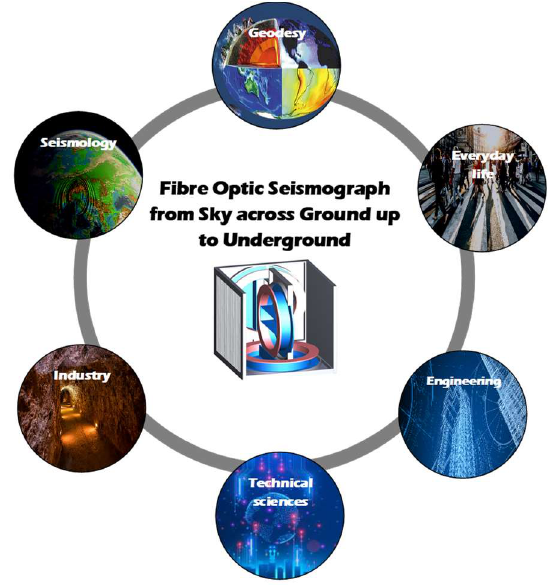
Figure 1. Visualization of three-axial fibre-optic seismograph with its wide range of applications.